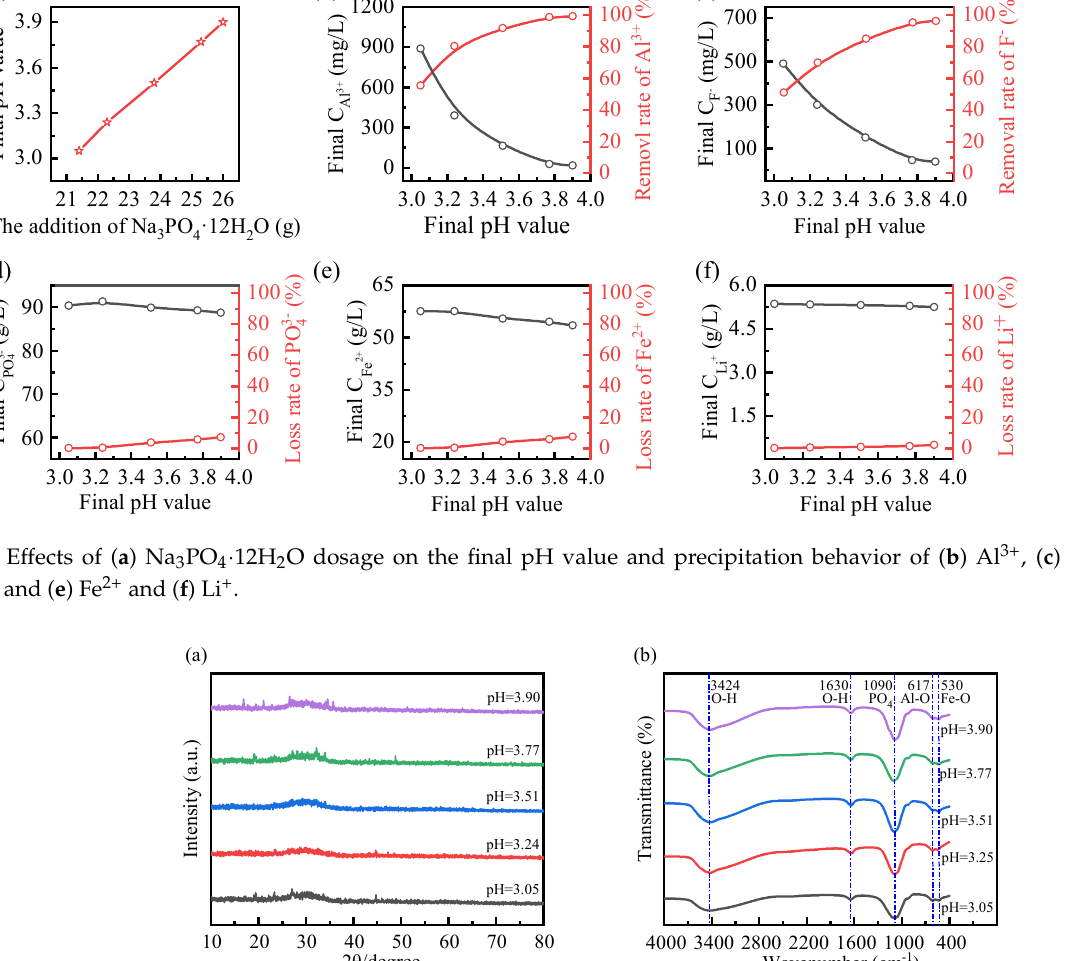
Figure 4. Effects of ( a ) Na 3 PO 4 ·12H 2 O dosage on the final pH value and precipitation behavior of ( b ) Al 3+ , ( c ) F − , ( d ) PO 43 − and ( e ) Fe 2+ and ( f ) Li + .